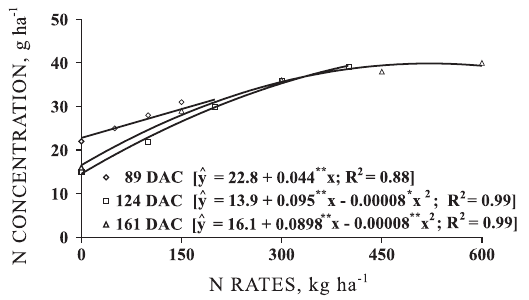
Figure 6. N concentration in Bermuda grass leaf blades, after N applications, in three